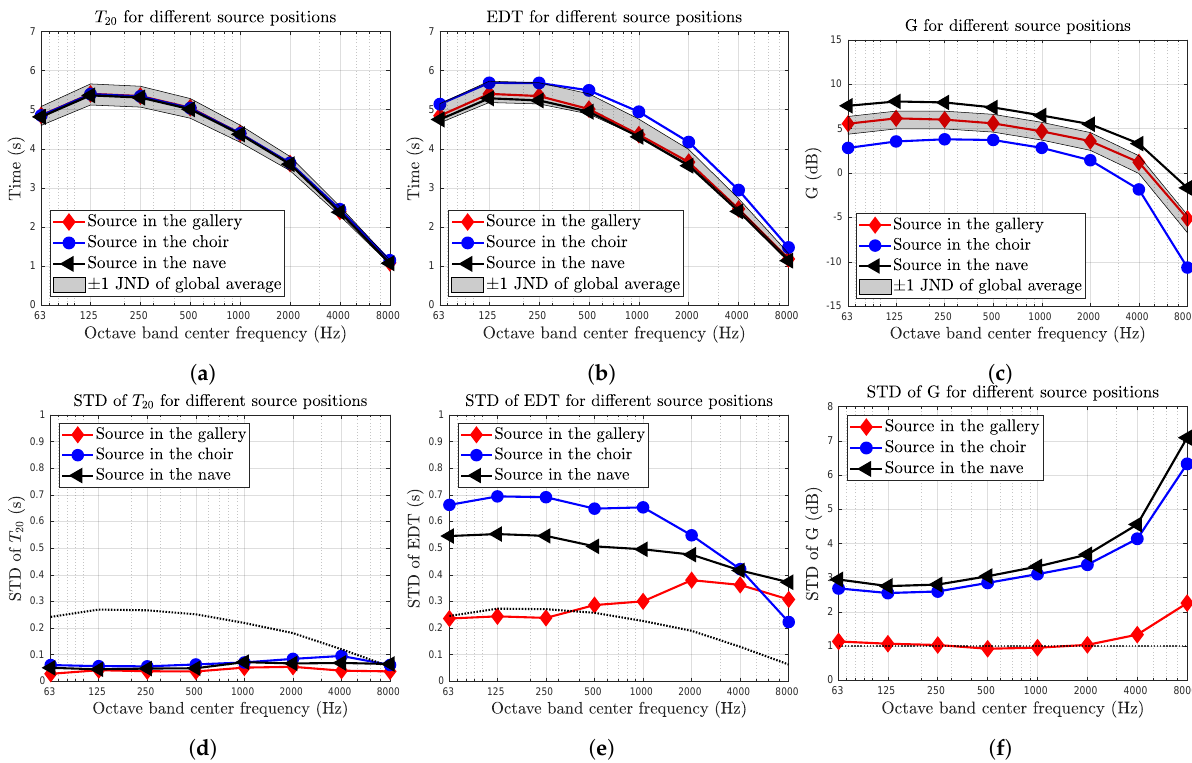
Figure 13. Overview of room acoustic parameters in the reconstructed church. Results are shown for three different source positions in octave band resolution. ( a ) The average T 20 and ( d ) its standard deviation. ( b ) The EDT and ( e ) its standard deviation. ( c ) The G and ( f ) its standard deviation. All standard deviations are shown compared to the global average JND of that parameter (dotted line). The gray areas in graphs ( a – c ) delimit values within 1 JND of the global average.